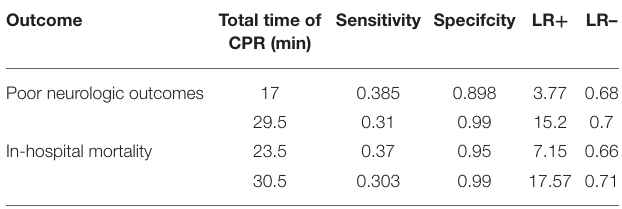
TABLE 3 | Best predictive power of the total time of CPR (min) for outcomes at discharge.